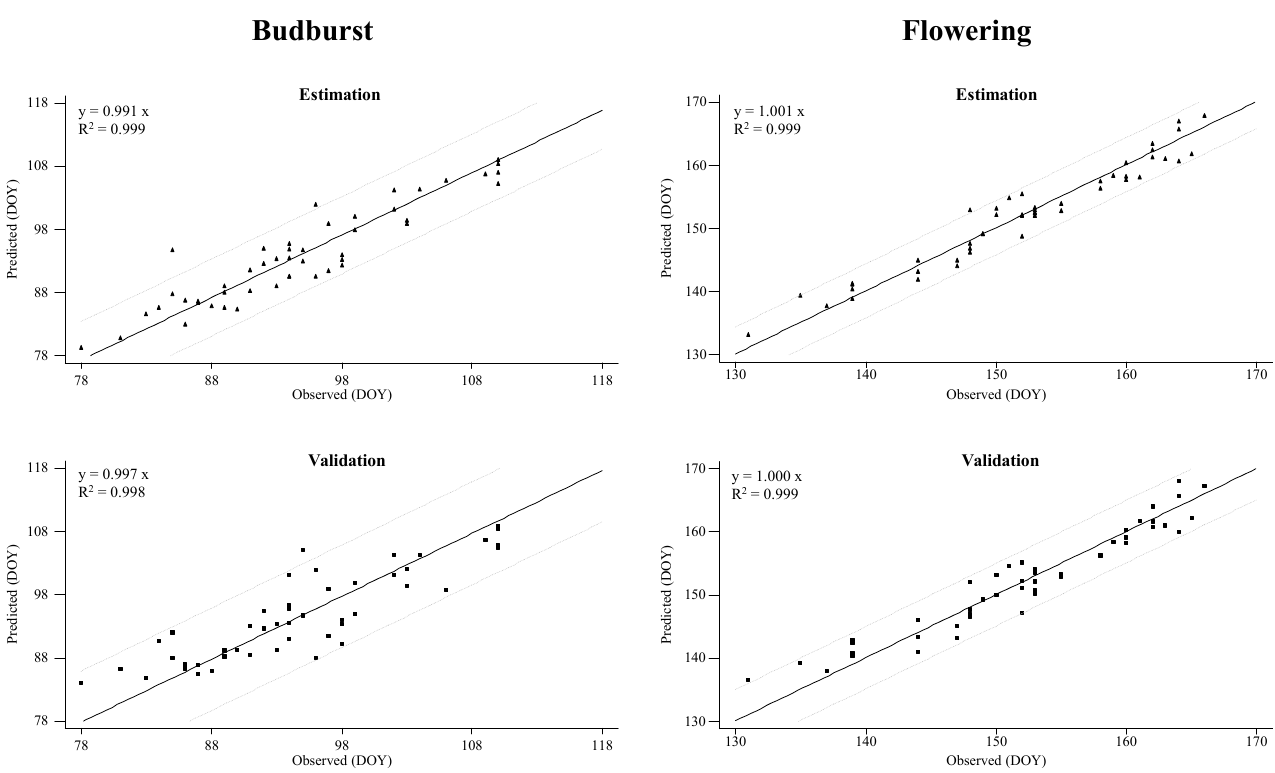
Figure 3. Predicted and observed dates using the Treixadura GDD model for budburst stage and Godello GDD model for the flowering stage. Closed triangles ( (cid:0) ) represent data used for the model estimation and closed square ( ▪ ) represent data used for the model validation. A 95% Confidence interval is represented by the gray dashed line.